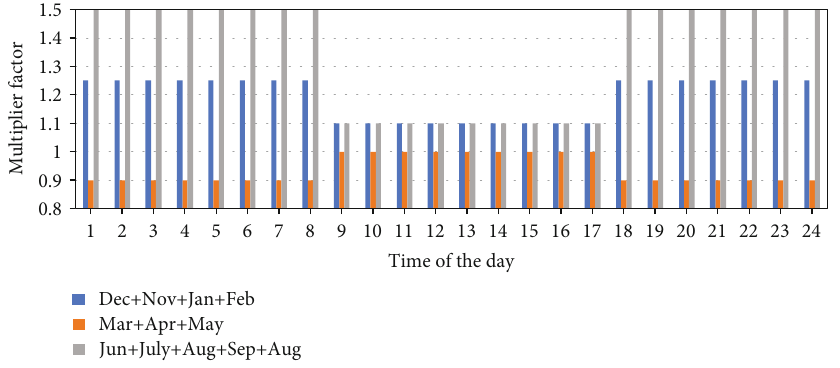
Figure 1: Proposed PPA agreement between the power plants and the consumer in